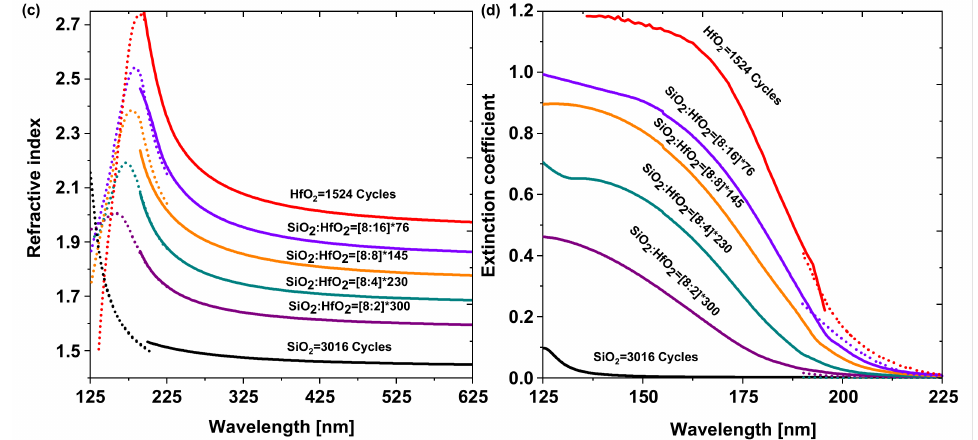
Figure 4. Comparison of optical constants as a function of wavelength estimated from VUV and UV–vis measurements for ( a , b ) 4 and ( c , d ) 8 cycles of SiO 2 .